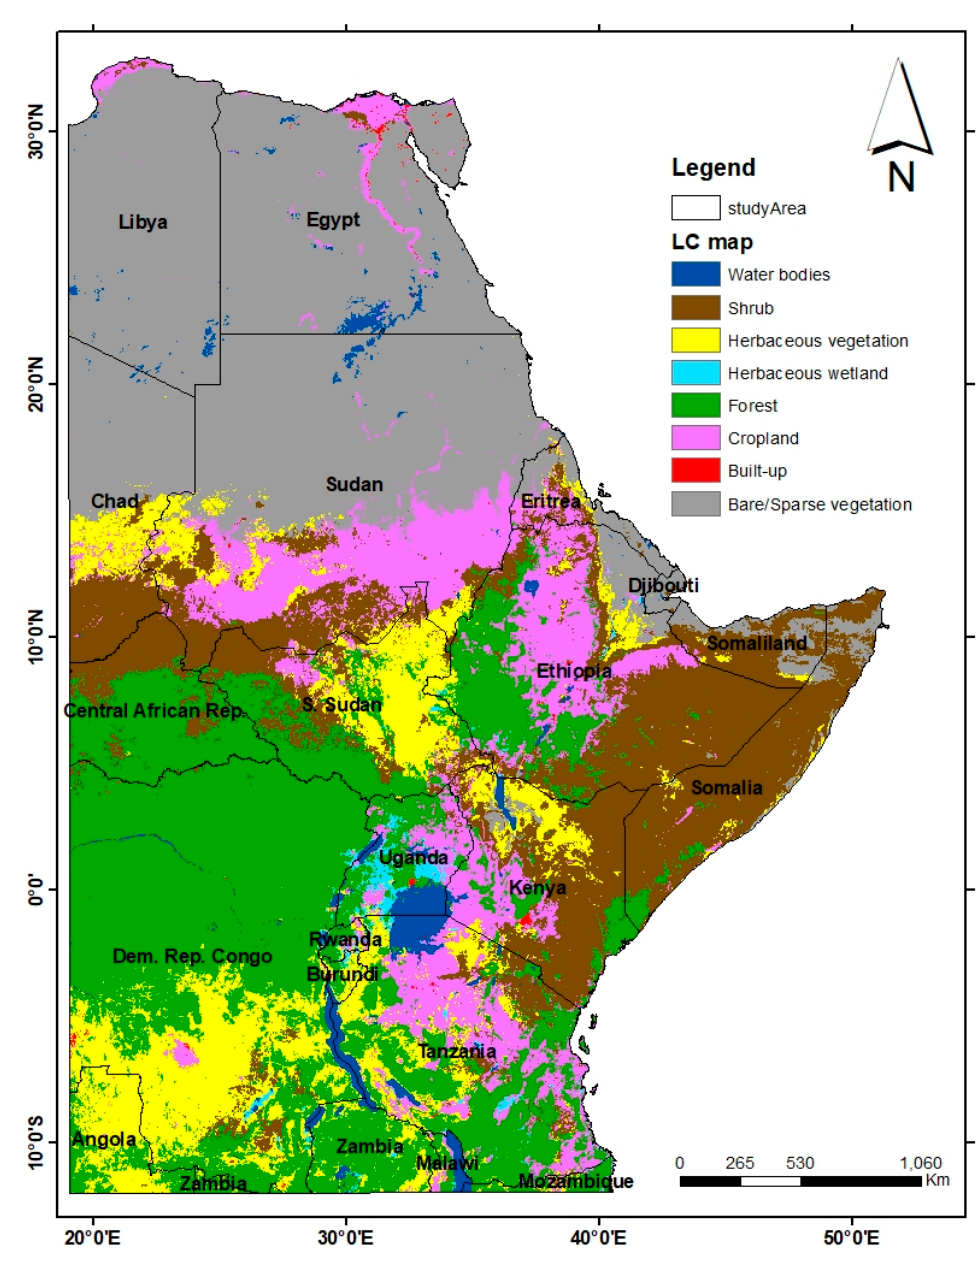
Figure 8. Land cover map of the study